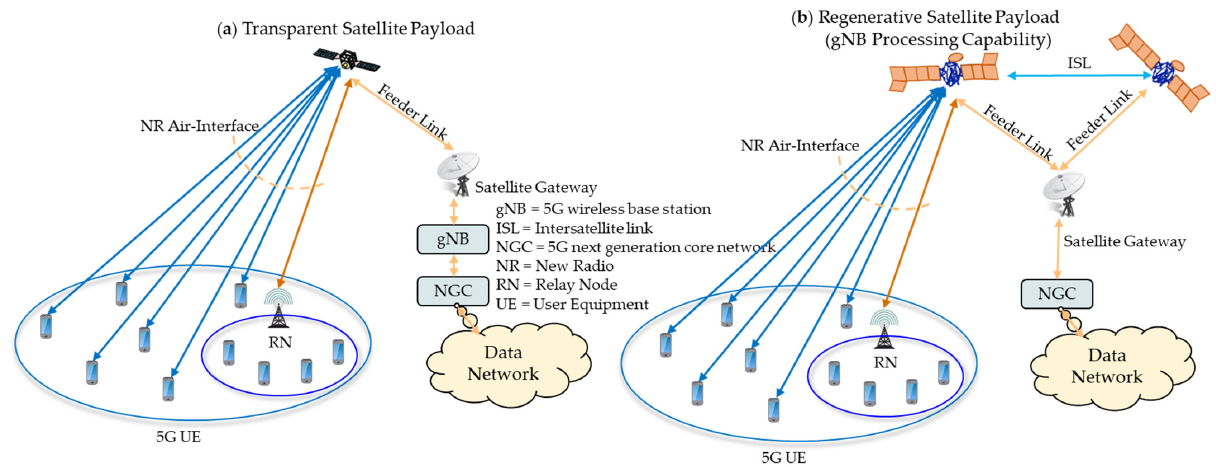
Figure 2. SATis5 Architectures for ( a ) Transparent and ( b ) Regenerative Satellite Payloads.